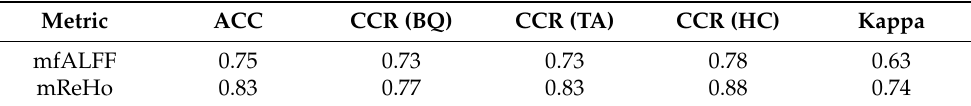
Figure 3. The confusion matrix of multiclass classification for ( a ) LR-mfALFF and ( b ) LR-mReHo. Table 2. Results of multiclass classification. Classification accuracy and Cohen’s kappa coefficient of LR with each imaging method from leave-one-out cross-validation. ACC, accuracy; CCR, correct classification rate; Kappa, Cohen’s kappa coefficient.